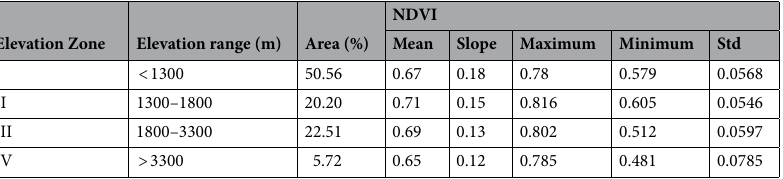
Table 1. The characteristics of NDVI value under different elevation from 1987 to 2018 of Qin Mountains.